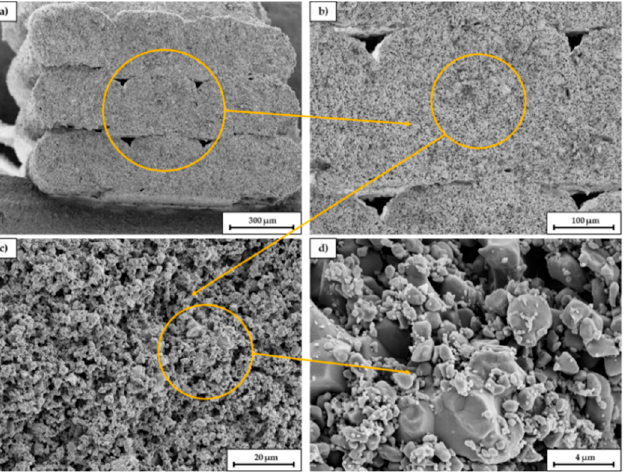
Figure 11. SEM images of a fracture surface of a sintered C2 based scaffold. The magnification increases from ( a ) to ( d ), the orange circle is the enlarged area.